Question: Generate an informative caption for the figure above.
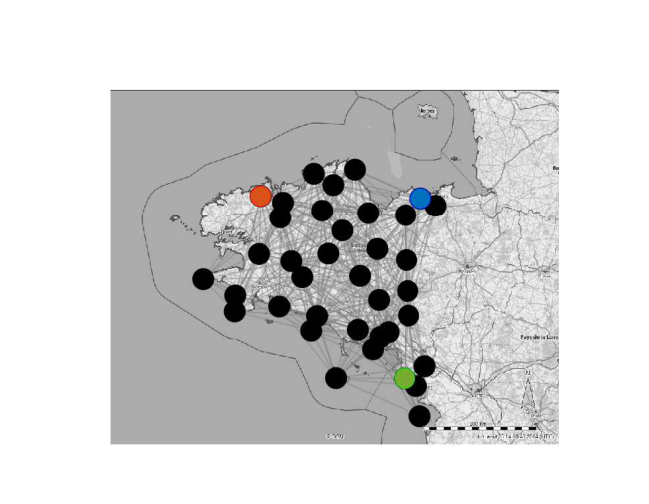
Answer: Geographical distribution of Brittany ground station, with selected cities highlighted for detailed analysis.